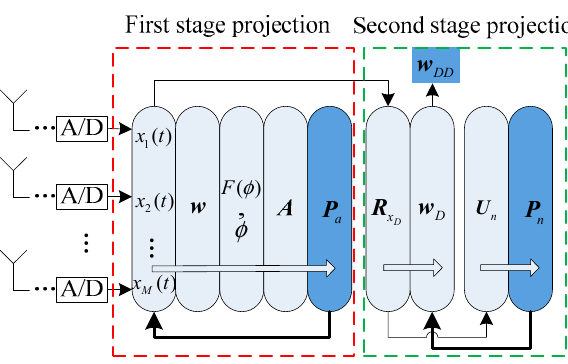
Figure 19. The schematic diagram of the signal processing flow of the double projection algorithm.